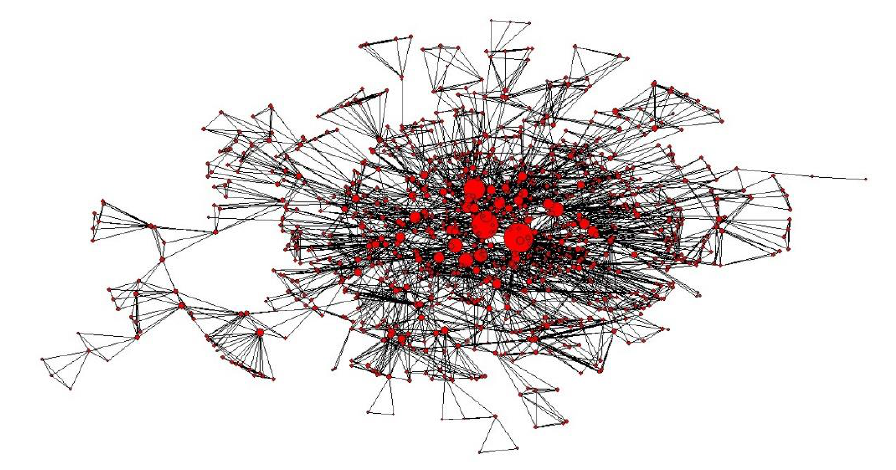
Figure 3. Network Related to Degree (year: